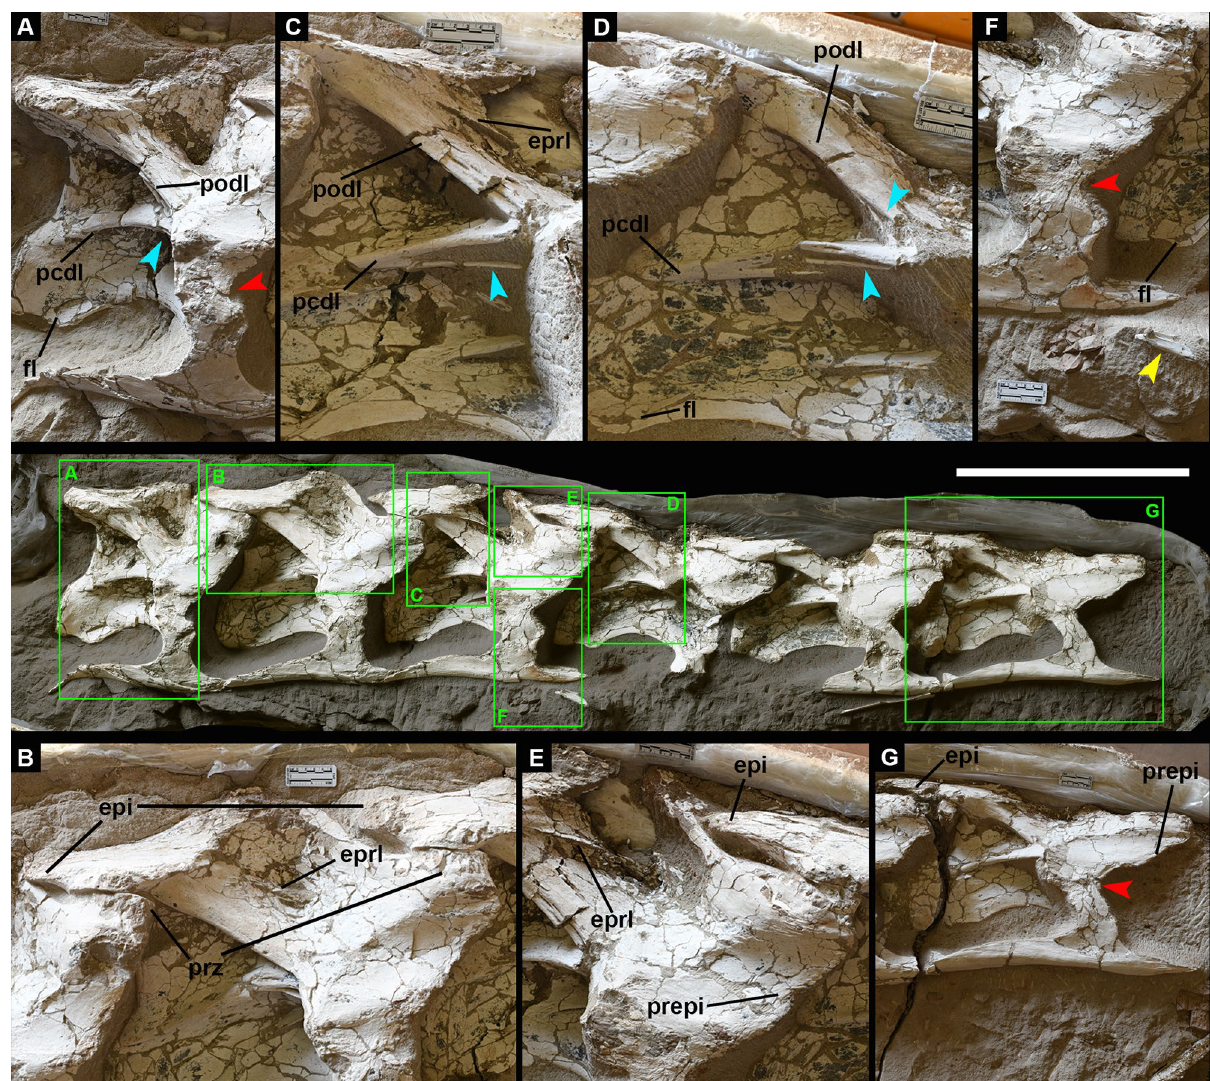
Figure 3. Silutitan sinensis gen. et sp. nov. (holotype-IVPP V27874) in left lateral view. Squares separated by letters indicate relevant anatomical details. ( A ) Posteriormost cervical vertebrae, with the bifurcated pcdl (posterior centrodiapophyseal lamina) and podl (postzygodiapophyseal lamina). ( B ) Articulation of cervicals 14 and 15, showing the epiphophysis (epi) and the epipophyseal–prezygapophyseal lamina (eprl). ( C ) Cervical vertebrae 13 showing details of the eprl, podl and pcdl. ( D ) Cervical vertebrae 12 showing details of the podl, pcdl and the fl (flange). ( E ) Cervical vertebrae 12 and 13 with “pre-epipophysis” (prepi), visible eprl and markedly epipopophysis (epi). ( F ) Cervical vertebra 13 showing well developed lateral flange close to the centrum posterior end. ( G ) Cervical vertebra 11, with markedly “pre-epipopophysis” (prepi) together with developed epipophysis. Red arrows show the constricted anteroposteriorly diapophyses-tuberculum contact. Blue arrows highlight laminae bifurcations. Yellow arrow indicates associated pterosaur lower jaw. Scale bar: 50